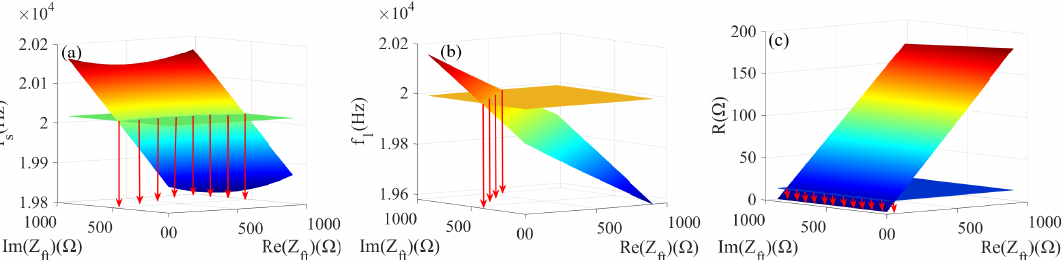
Figure 11. ( a ) The intersection mapping of f s ; ( b ) The intersection mapping of f 1 ; ( c ) The intersection mapping of R